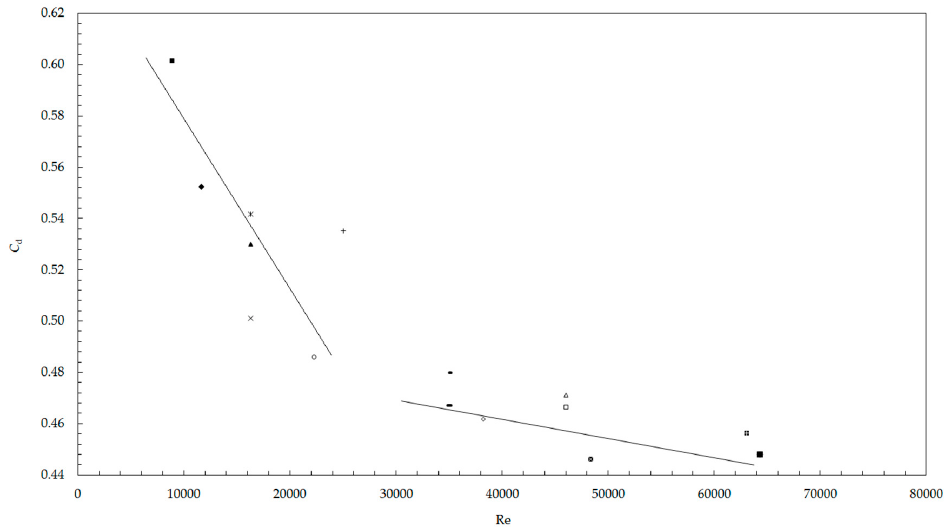
Figure 5. Discharge coe ffi cients ( C d ) versus Re, Series 1.